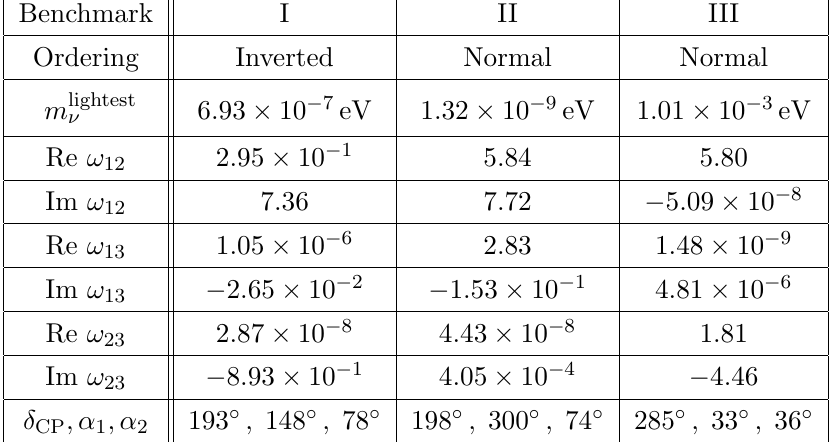
Table 2 . Input parameters for the discussed benchmark